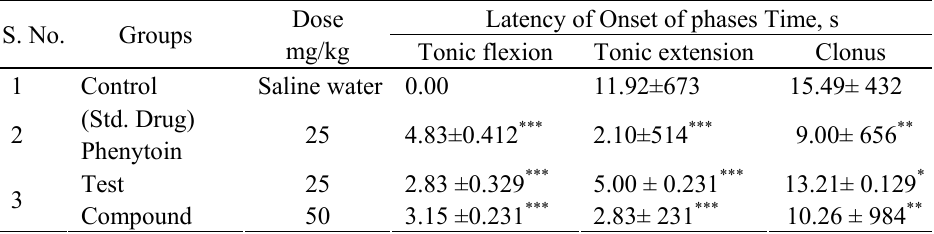
Table 4. Data of Anticonvulsant activity of Synthetic Compound Phenytoin on MES- induced seizures in